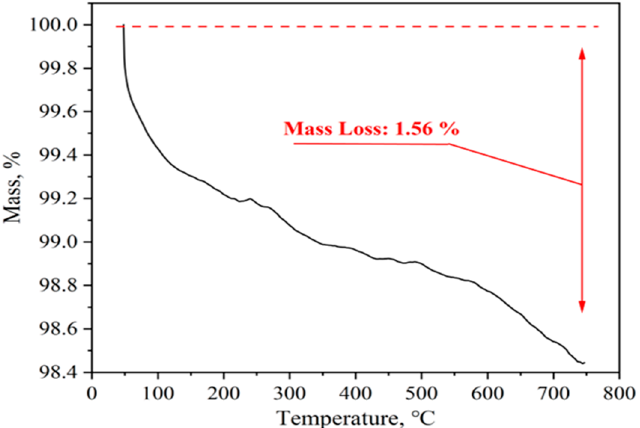
Figure 5. Thermogravimetric Analysis (TG) images of chemocatalyst UST-Sn-RH. TG was analyzed at a temperature ramping of 10 °C min − 1 from 50 to 750 °C under nitrogen atmosphere to detect the weight loss of the sample.